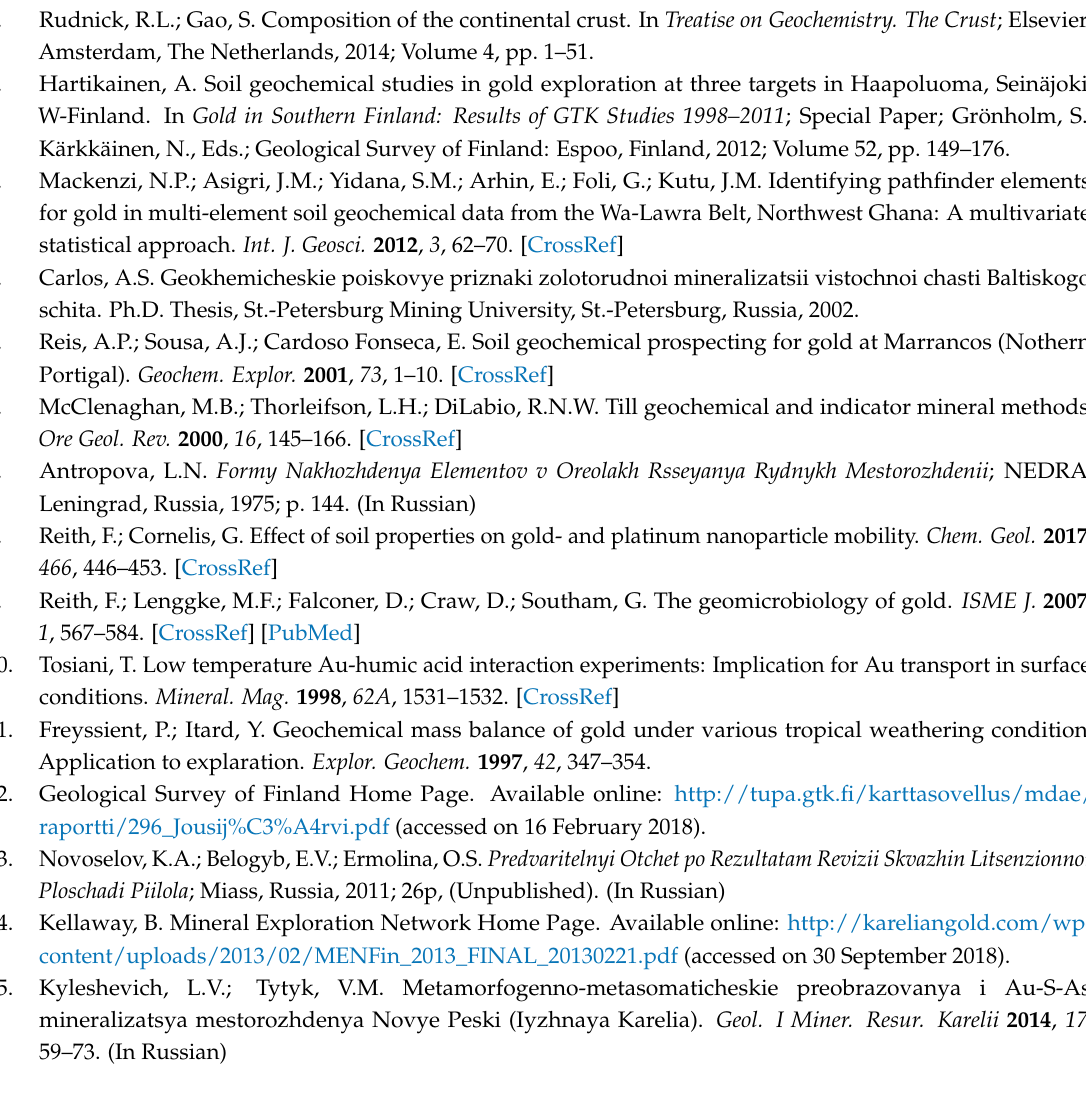
Figure S1: X-Ray Diffraction results of surface sediments in the Piilola area, Figure S2: Mineralogical characteristic of bedrock in the Piilola area, Figure S3: X-Ray Diffraction results of surface sediments at Novye Peski, Figure S4: Mineralogical characteristic of bedrock at Novye Peski. Table S1: Concentration of different forms of gold in surface sediments